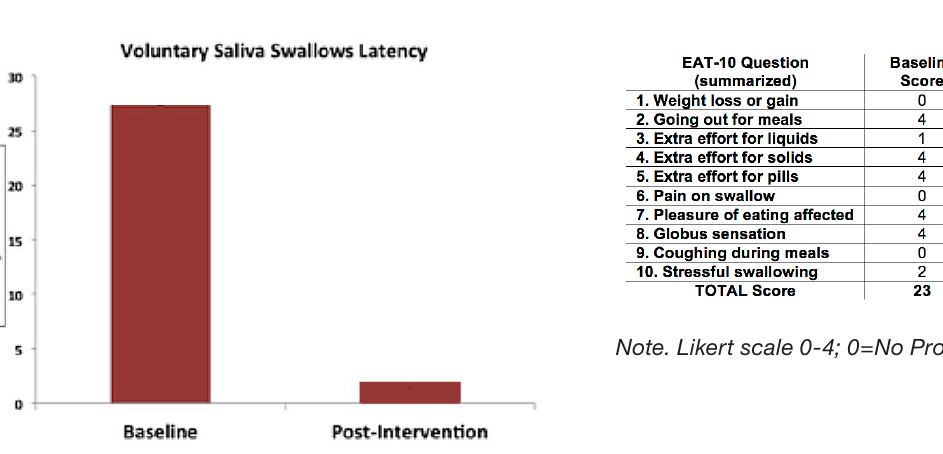
Figure 3. Latency of voluntary saliva swallows at baseline and post-intervention; results were based on one trial at baseline and on three trials post-intervention.